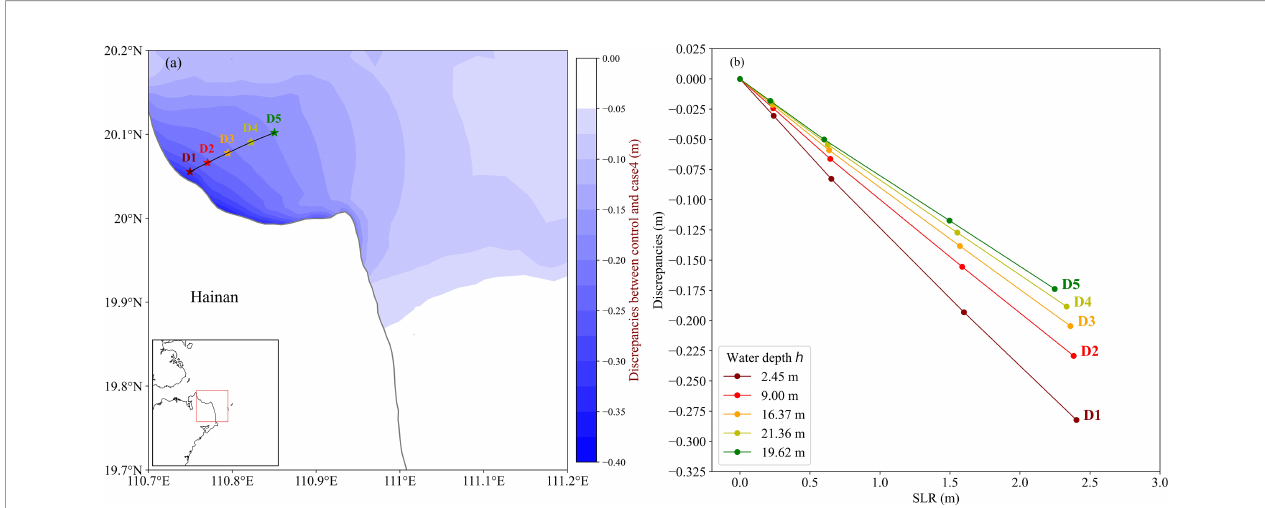
FIGURE 11 | (A) Selected fi ve representative nodes at the northeastern coast of Hainan Island. The background contour shows the peak surge difference (m) between the base case (Test 5) and SLR scenario in year 2300. (B) Peak surge differences between the base case and different SLR scenarios at the fi ve